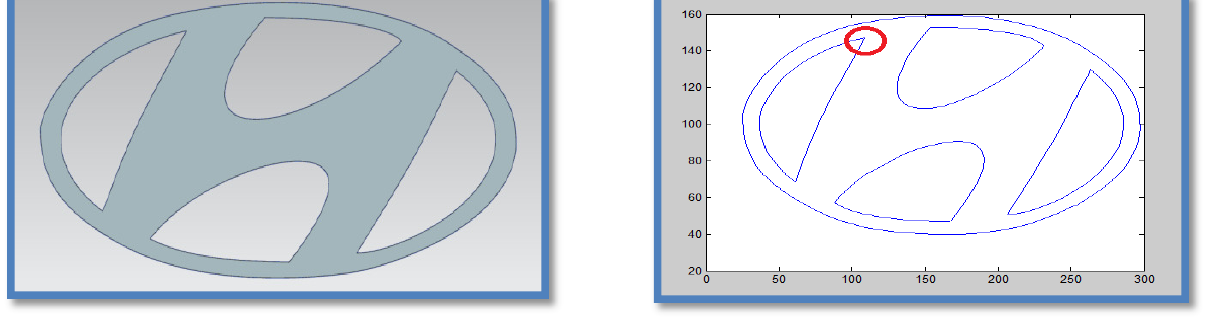
Fig. 3. Model generation using UG-NX program.